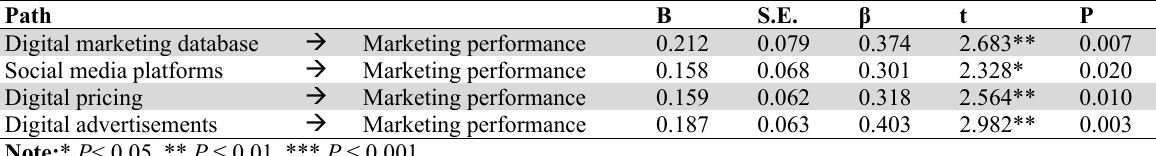
Effect coefficients of DCMM on